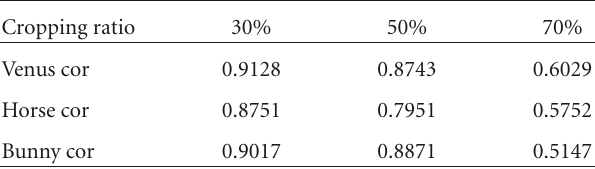
Table 2: Results of cropping and noise